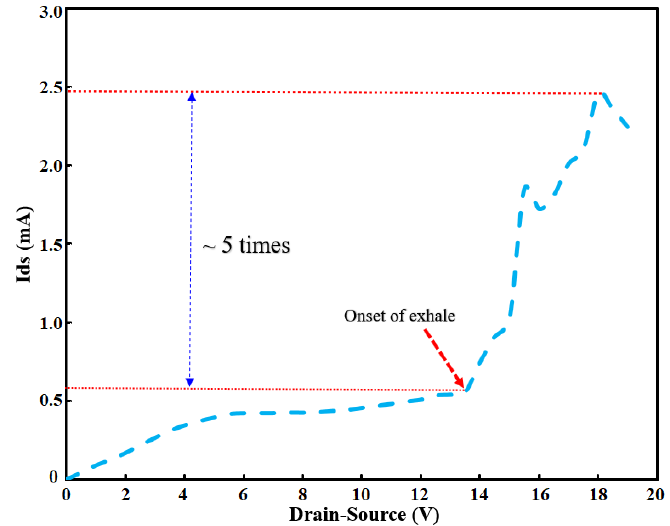
Figure 13. The result of the human exhalation test on the OG-JFET.